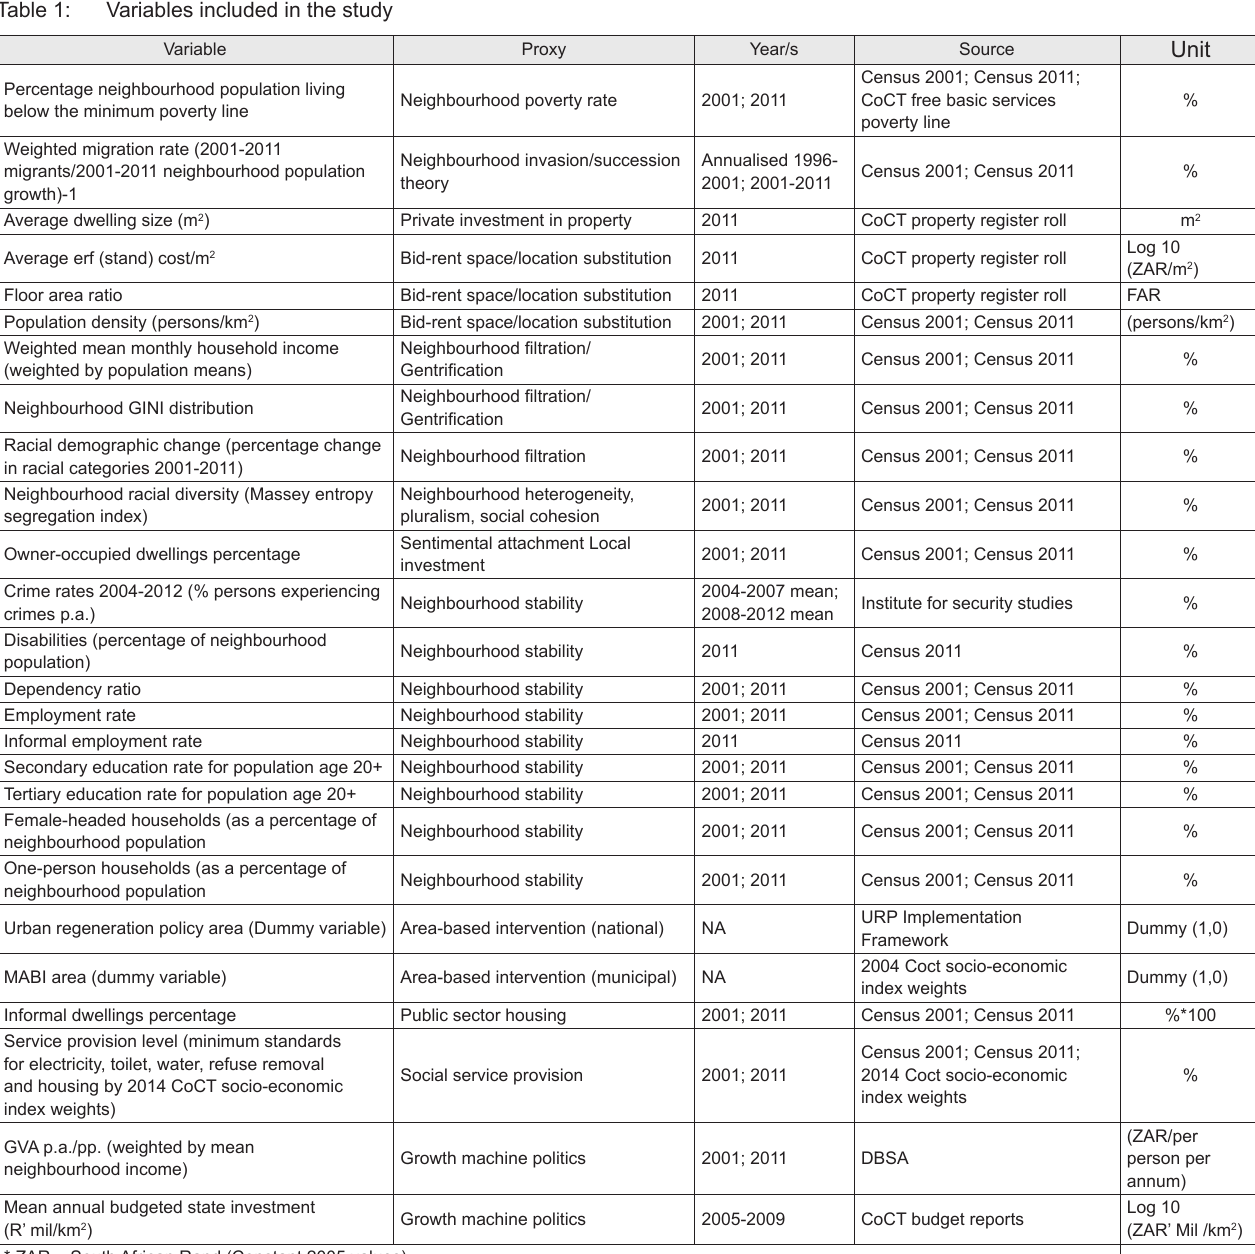
Table 1: Variables included in the study